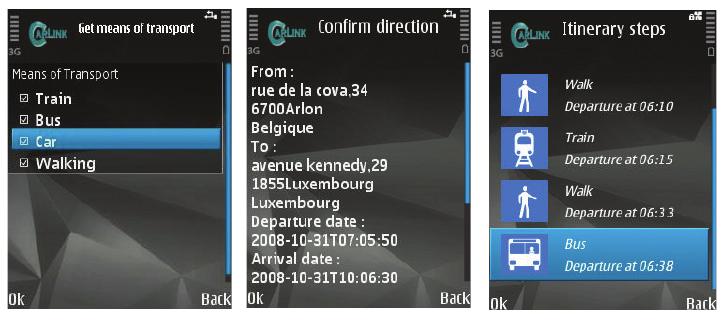
Figure 7: Screenshots of the application for mobile devices. Selecting the preferences for the traveling, confirming and showing the itinerary steps.